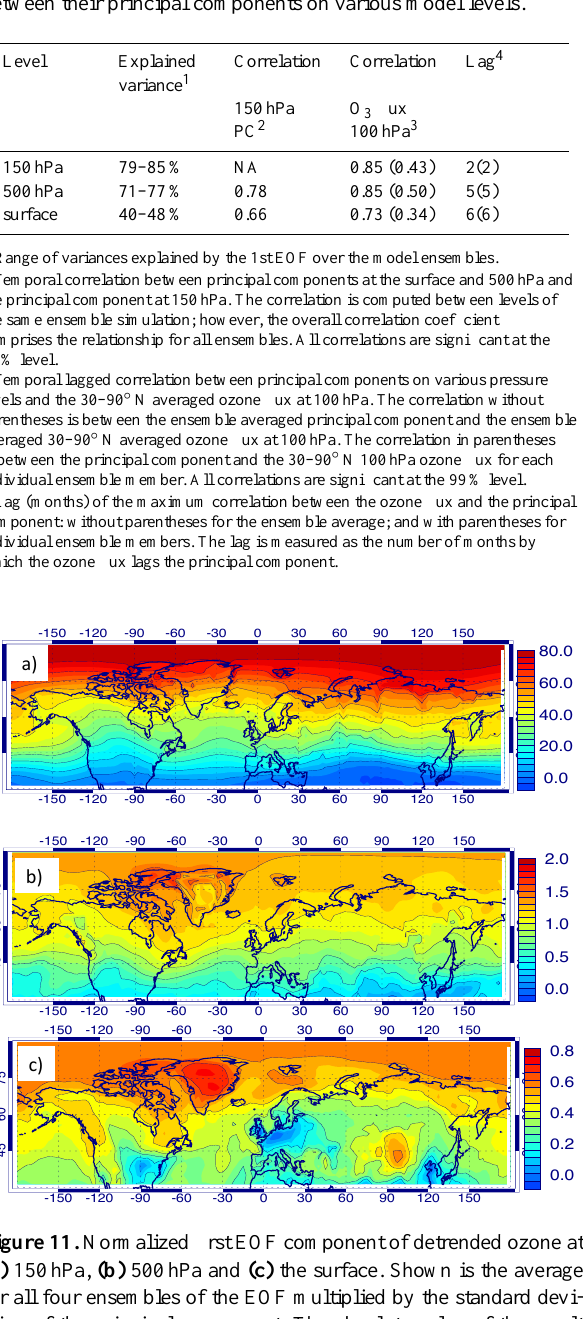
Table 4. Explained variances of the first EOF and the correlations between their principal components on various model levels.